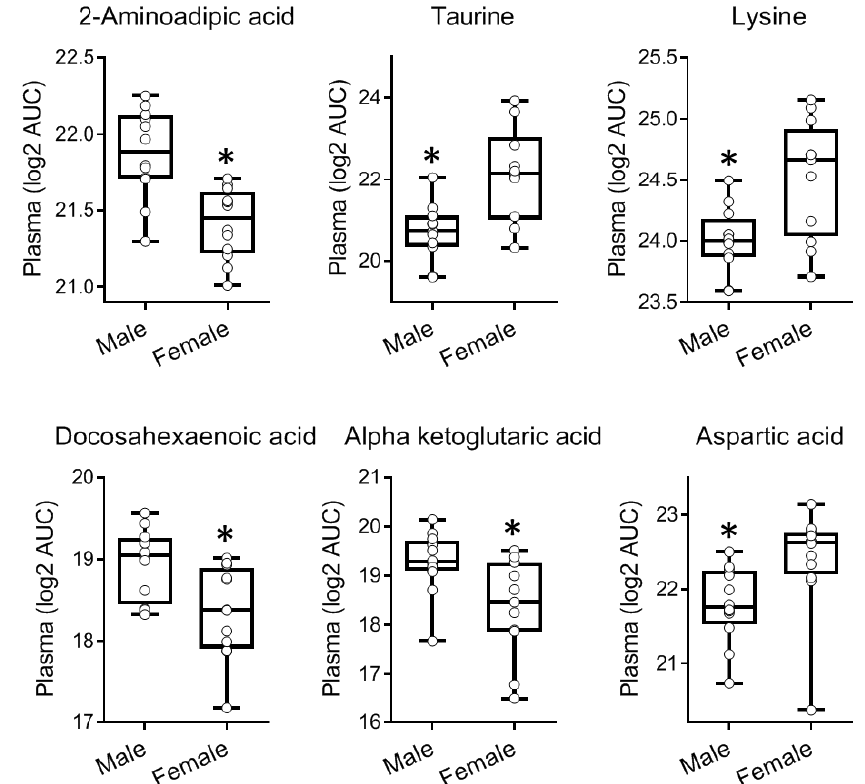
Figure 8. Metabolites showing significant differences in plasma levels in male versus female nondiabetic C57BL/6 mice ( n = 12; 6M + 6F). Data are shown as Box and Whisker plots with individual datapoints corresponding to each sample shown as round symbols. Asterisk denotes p < 0.05 by unpaired t -test.